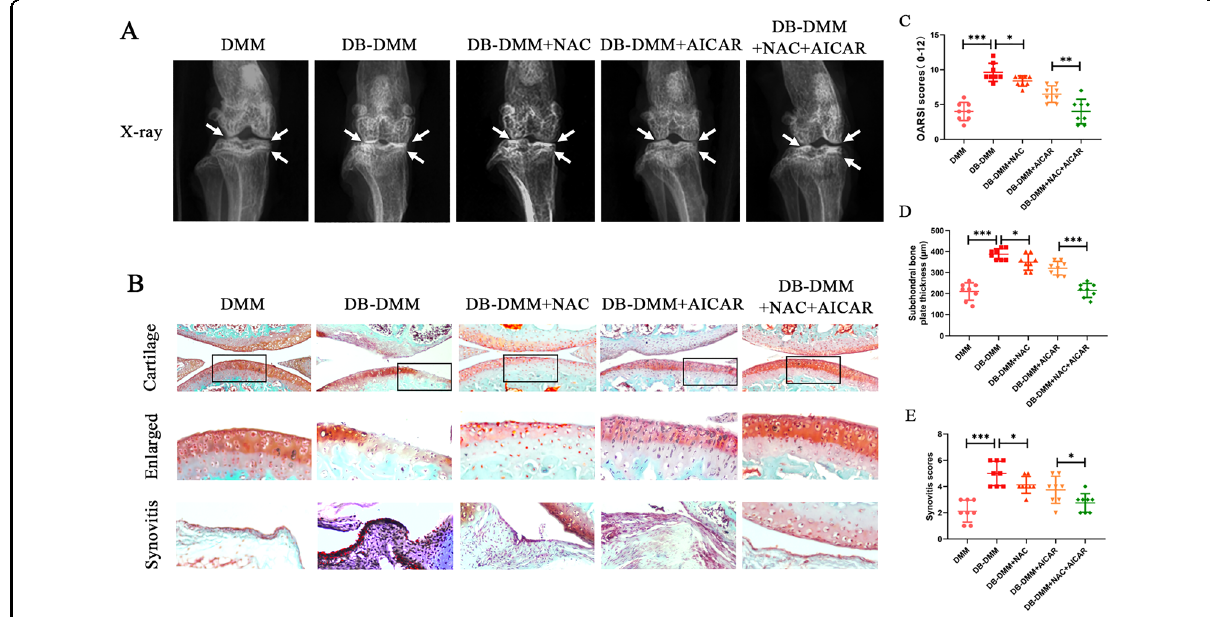
Fig. 6 NAC and AICAR ameliorate DB-accelerated OA development in a DB-DMM mouse model in vivo. A Digital X-ray image of mice knee joints in the various experimental groups. Joint space, calci fi cation of the cartilage surface, and osteophyte formation are represented by white arrows. B Representative Safranin-O staining of cartilage and synovitis in various experimental groups at 4 weeks post surgery. C OARSI scores of cartilage. D . Subchondral bone plate thicknesses. E Synovitis scores. Data are presented as means ± SD ( n = 8). * P < 0.05, ** P < 0.01 and, *** P <